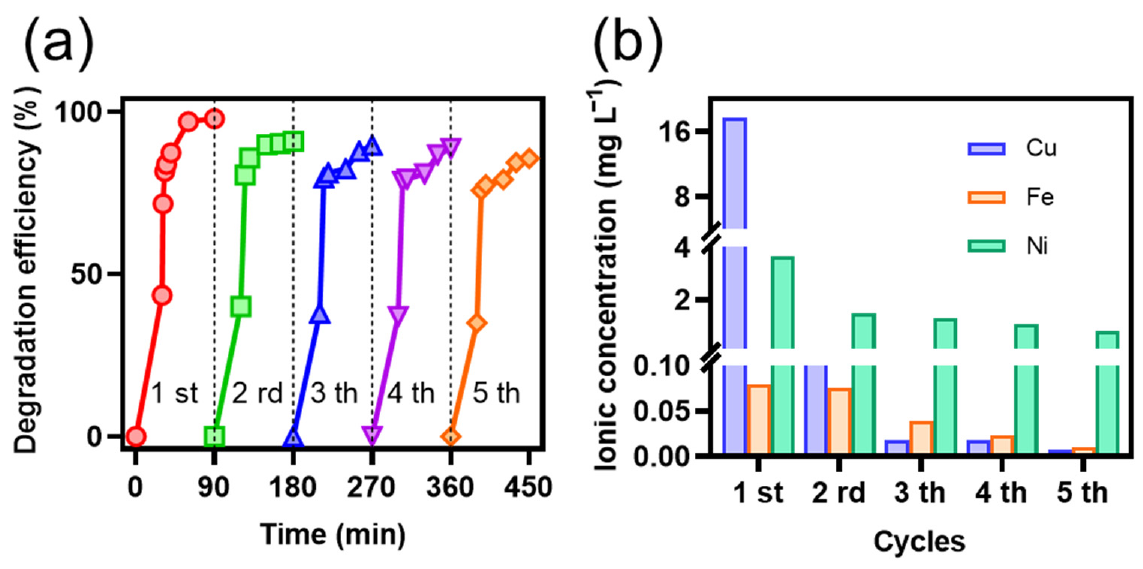
Figure 5. ( a ) The TC degradation efficiency over five cycles in CFO-NF/PMS system, and ( b ) ion dissolution over five cycles in CFO-NF/PMS system (PMS: 0.4 mM, TC: 10 mg L − 1 , catalysts: 4 pieces, 25